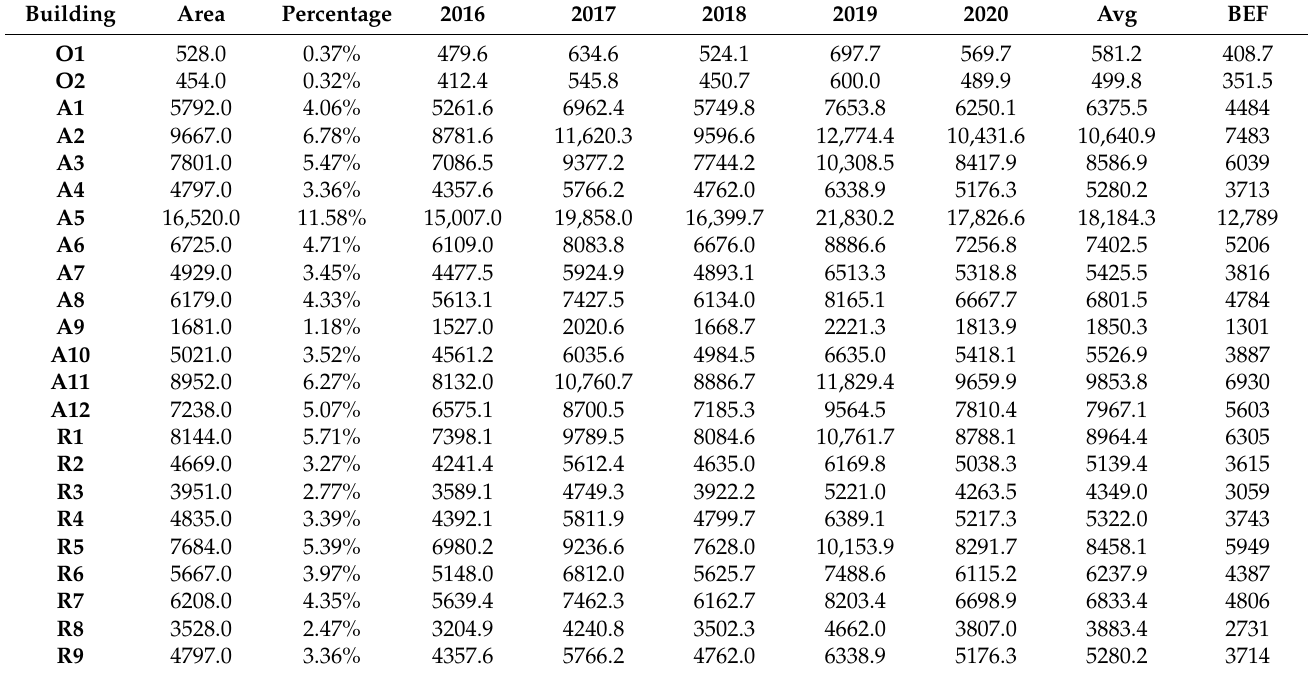
Table A3. Water calculation based on the area-ratio method.